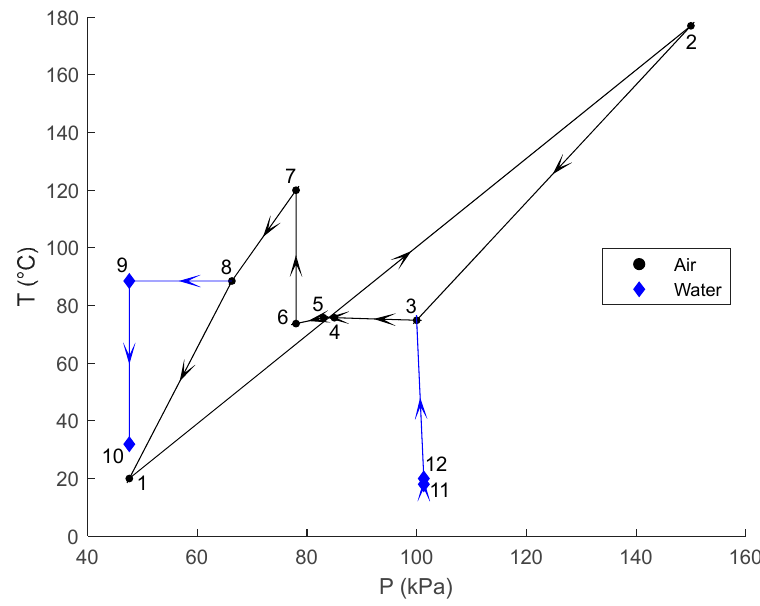
Figure 2. T-P diagram for the baseline cycle.